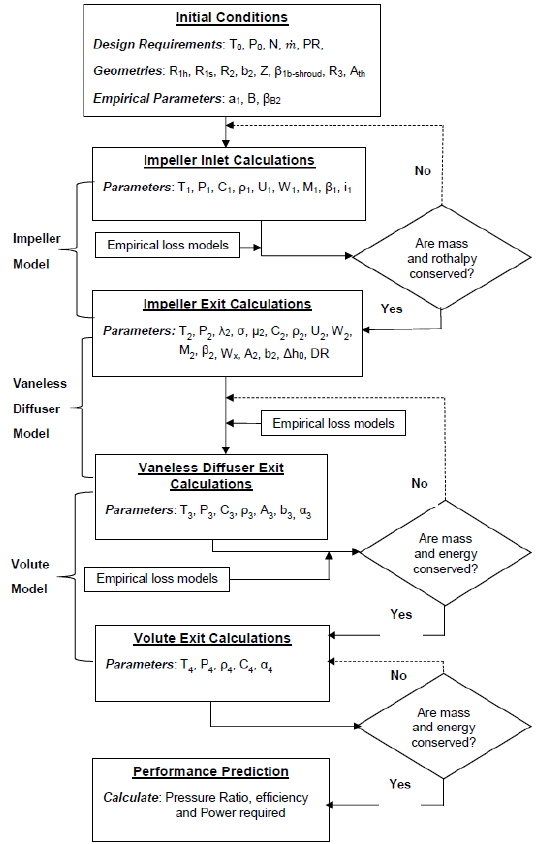
Figure 4. Compressor modelling procedure flow diagram.